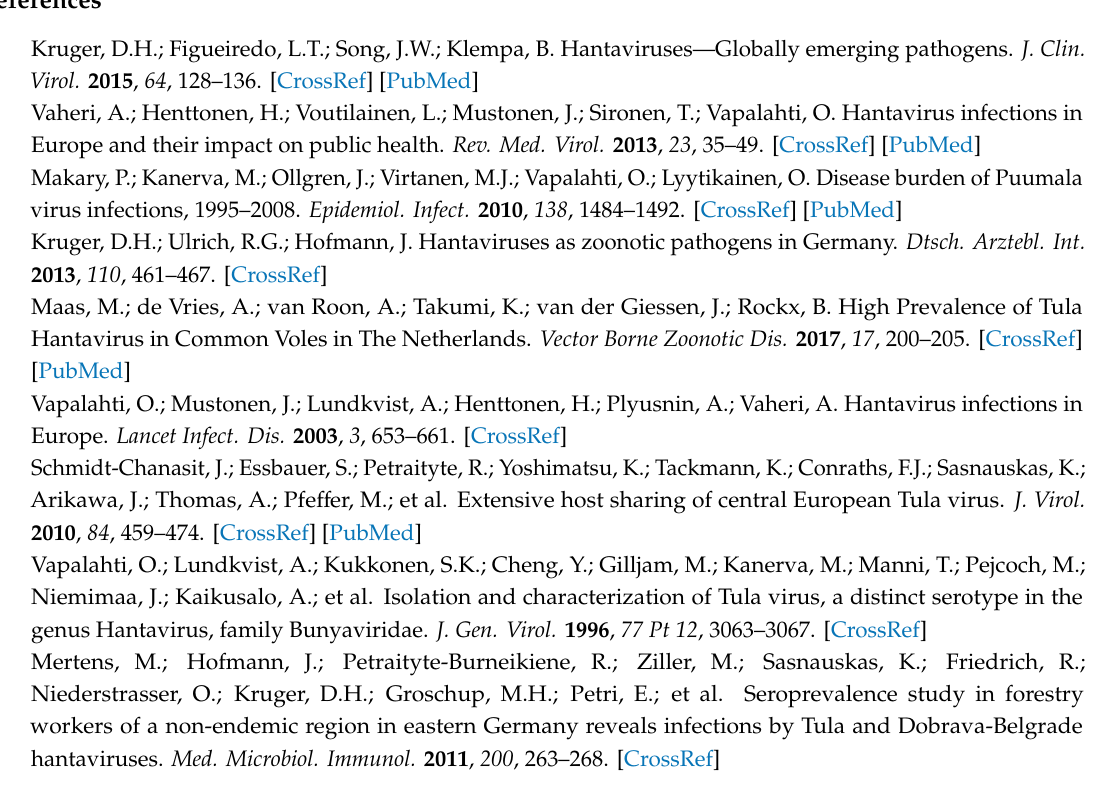
Figure S1: Quantification of viral RNA amplification in PUUV- and TULV-infected peripheral blood mononuclear cell (PBMC)-derived macrophages and human glomerular microvascular endothelial cells (HGMEC), Figure S2: Nucleocaspid protein expression in PUUV- and TULV-infected PBMC-derived M1 and M2 polarized macrophages, Figure S3: Nucleocaspid protein and MX1 expression in PUUV- and TULV-infected HGMECs, Figure S4: IFN- λ gene expression in response to PUUV or TULV infection, Figure S5: RNA replication kinetics of di ff erent PUUV and TULV strains, Figure S6: Nucleocaspid protein and MX1 expression in A549 cells infected with PUUV, UV-irradiated PUUV, or PUUV stocks depleted of infectious viruses, Figure S7: IFNL1 gene expression in PUUV- or TULV-infected Vero E6 cells, Figure S8: Integrin expression in THP-1 / PMA, A549, HMEC-1, and Vero E6 cells, Figure S9: IRF-activity in PUUV- and TULV-infected A549-Dual ™ reporter